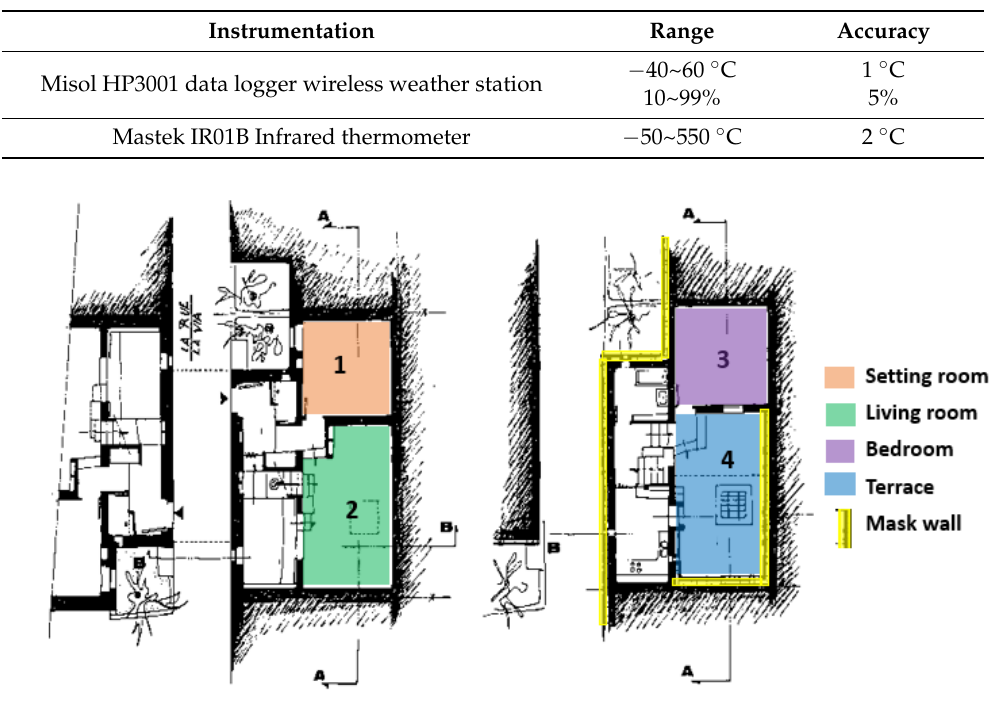
Figure 6. Instruments of measurement. Table 4. Instrumentation range and accuracy.